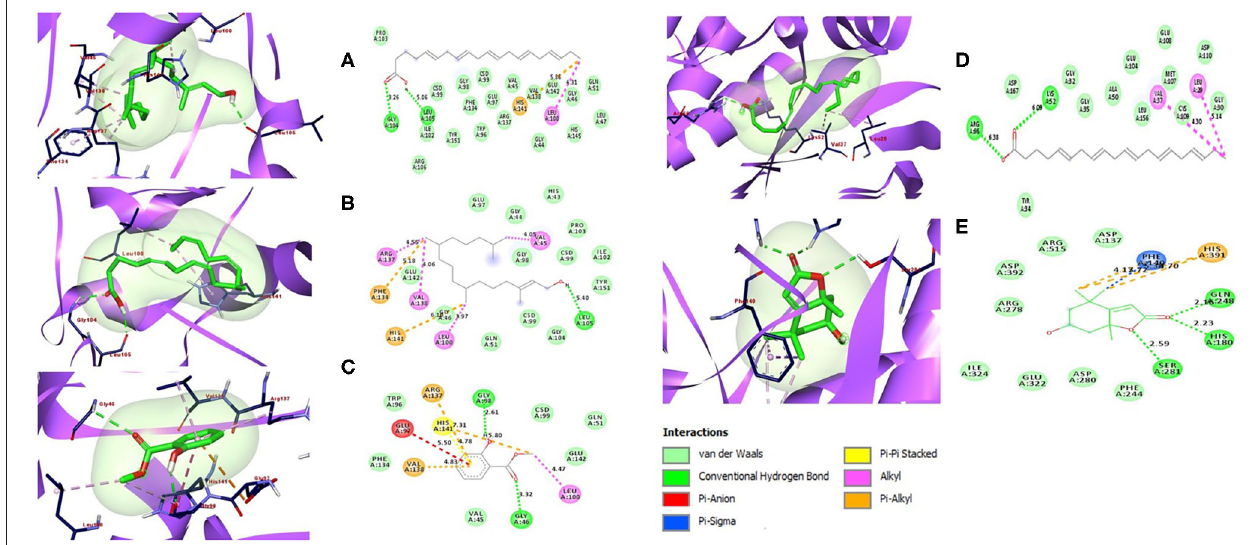
FIGURE 5 | Left panel showing 3D image of protein and ligand interaction while right panel is 2D interaction. (A) Molecular docking interaction of Eicosapentaenoic acid with PDF Xoo. (B) Molecular docking interaction of Phytol with peptide deformylase protein of Xoo. (C) Molecular docking interaction of Salicylic acid methyl ester with PDF of Xoo. (D) Molecular docking interaction of Eicosapentaenoic acid with MAPK1 of M. oryzae. (E) Molecular docking interaction of Loliolide with sucrose hydrolase (SUH)-glucose complex of Xag .